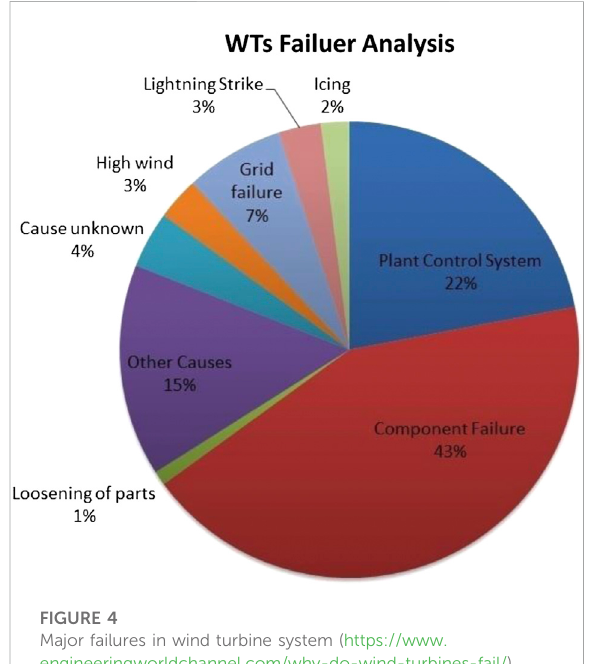
FIGURE 4 Major failures in wind turbine system